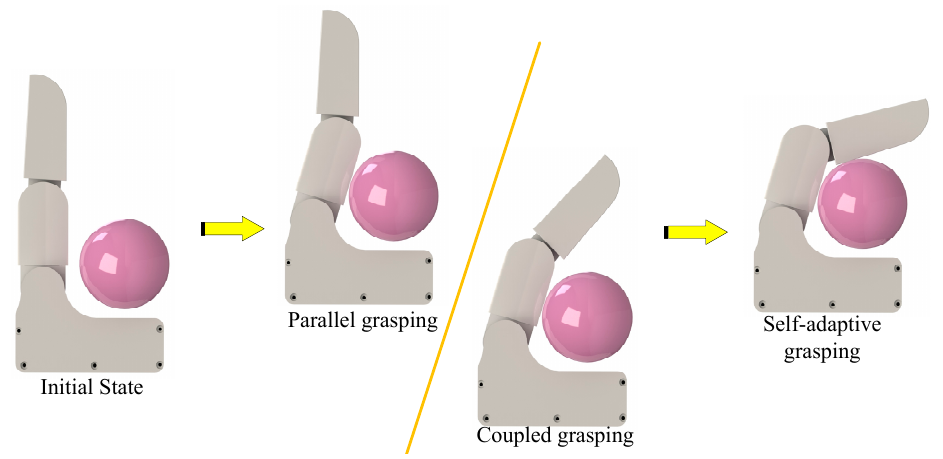
Figure 5. Grasping process of the ESMGM finger.